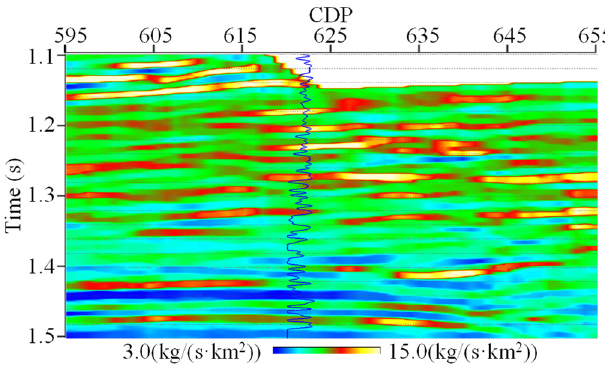
Figure 10. The inverted impedance profile.